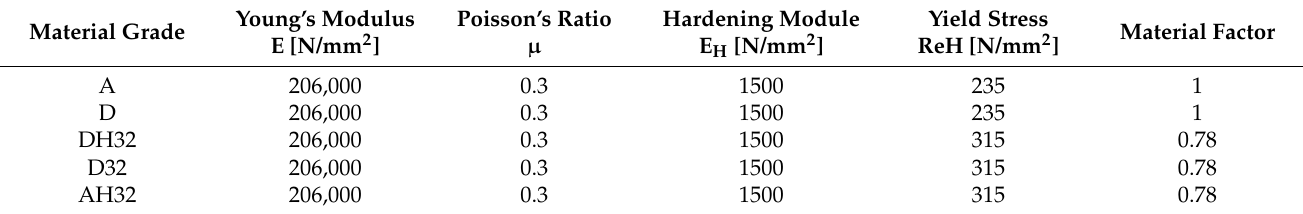
Table 3. Project material catalog.